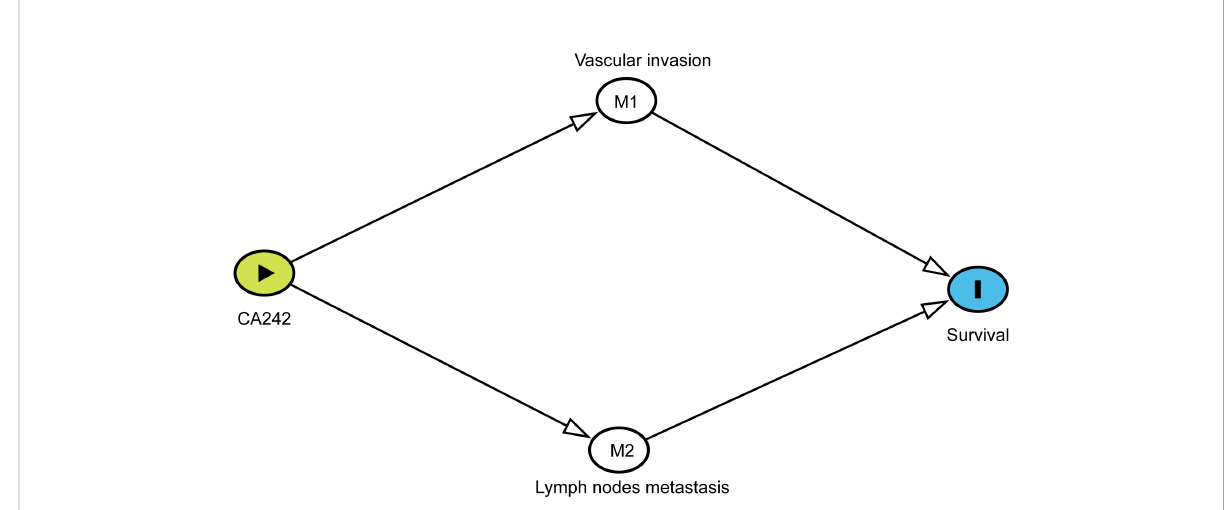
FIGURE 1 The DAG (Directed Acycling Graph) showing the relationship between CA242, vascular invasion, lymph node metastasis and prognostic